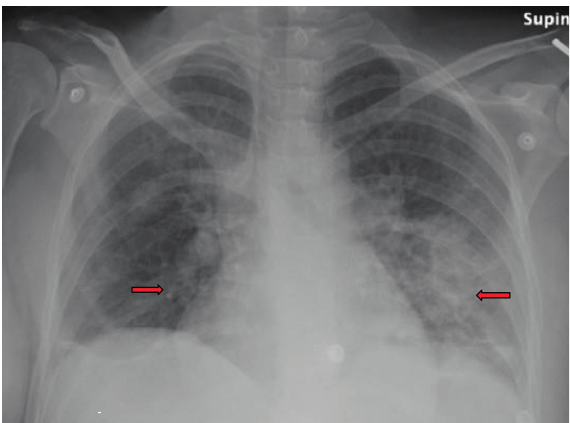
Figure 1: Chest X-ray revealed diffuse bilateral lower lobe pre- dominant airspace opacities with nodularity.